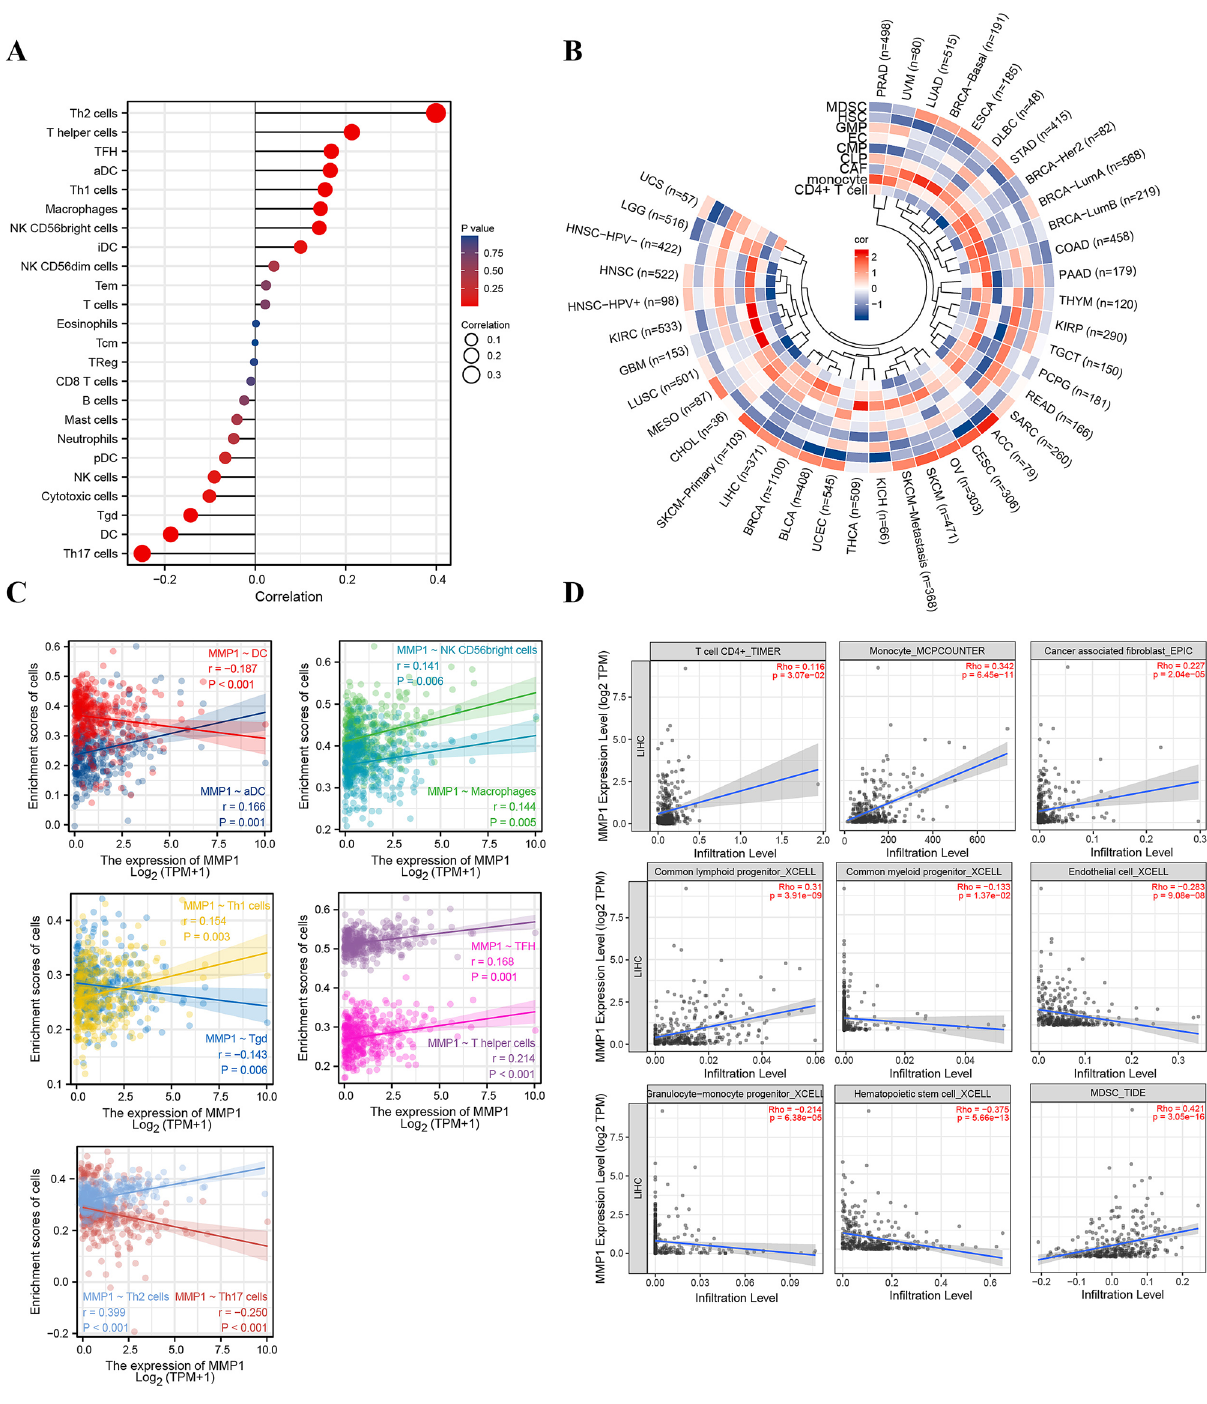
Figure 9. Multiple immune-related cells—MMP1 expression correlation analysis. ( A ) Lollipop plot of MMP1 expression and immune infiltration cells correlation in TCGA-LIHC; ( B ) Circle heatmap of MMP1 expression— immune-related factors correlation via TIMER2.0; ( C ) MMP1 expression and some types of immune-related cells; ( D ) Correlation analysis of other immune-related cells via TIMER2.0. * P < 0.05, ** P < 0.01, *** P <